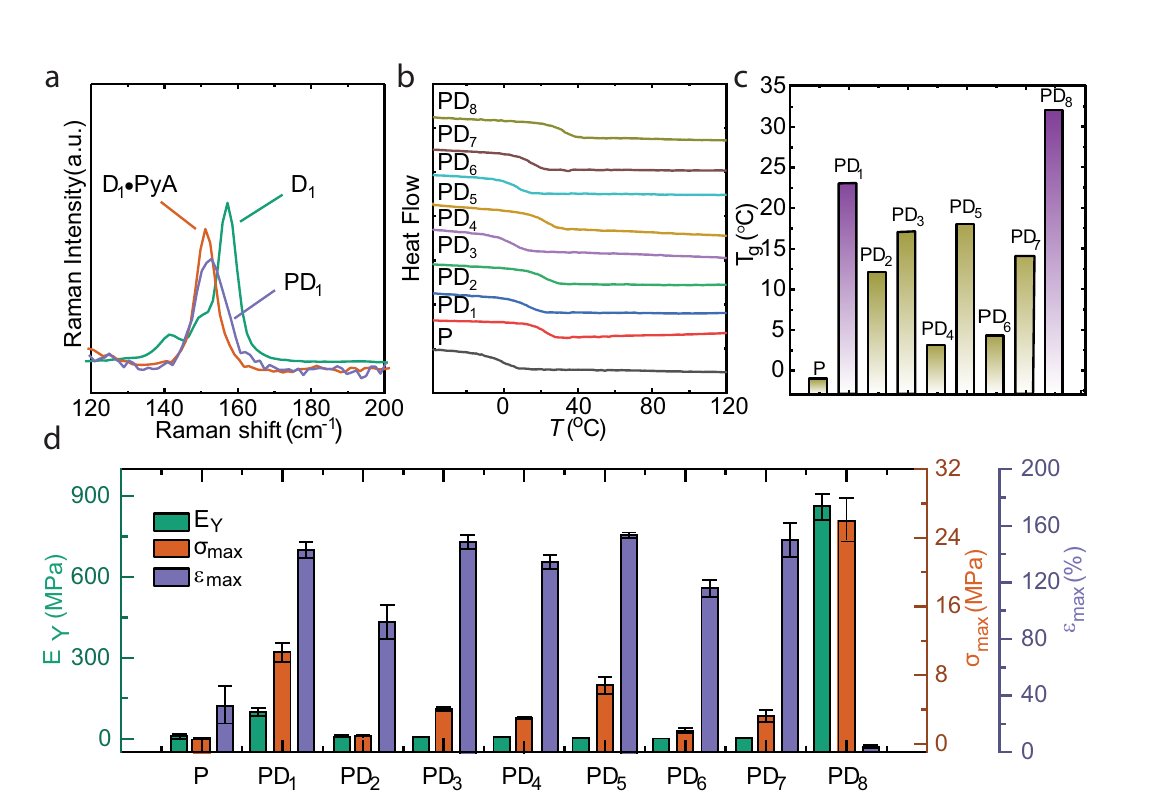
polymeric structure of PD 1 . Bottom: The halogen/hydrogen bond donors ( D 1 – D 8 ). DMPA is a photoinitiator, 2,2-dimethoxy-2-phenylacetophenone.